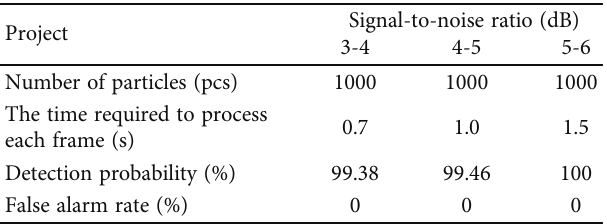
Figure 8: Root mean square error of target tracking position. Table 1: Comparison of detection performance of algorithms under three signal-to-noise ratios.